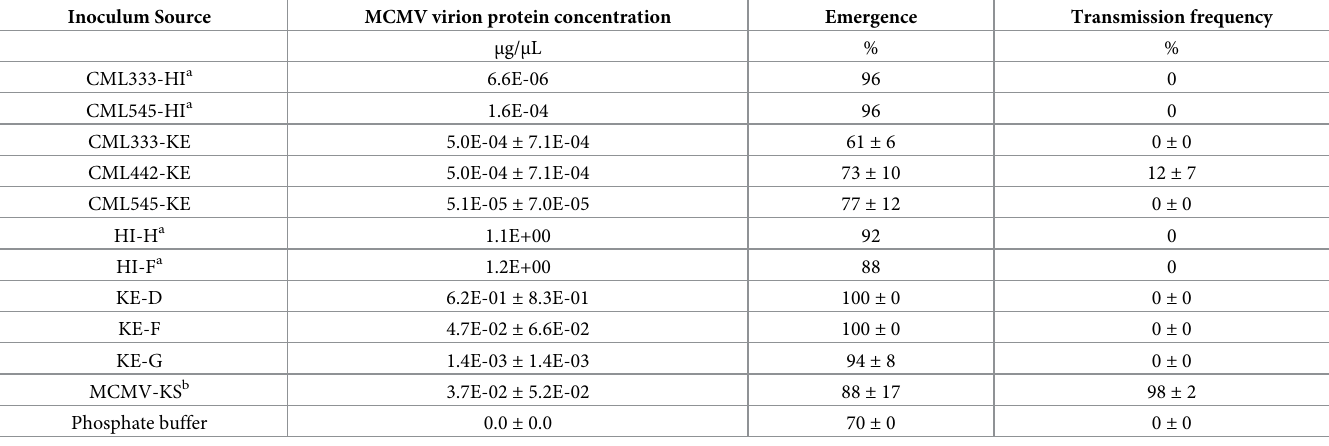
1.00E-05 and 1.00E-06 μ g/ μ l (S2 Table). VPI of seed with extracts of MCMV-positive CML333 or CML545 seed used in the grow-out study, did not result in consequent infection of any of the resulting 146 seedlings. For CML442, 12 ± 7% of 51 inoculated seedlings were positive for MCMV by RT-PCR. For the seed lots used in localization experiments, samples from Hawaii seed lots were concentrated by ultracentrifugation prior to inoculation. Extracts of the three Table 3. Transmissibility of maize chlorotic mottle virus (MCMV) from seed by vascular puncture inoculation. Inoculum Source